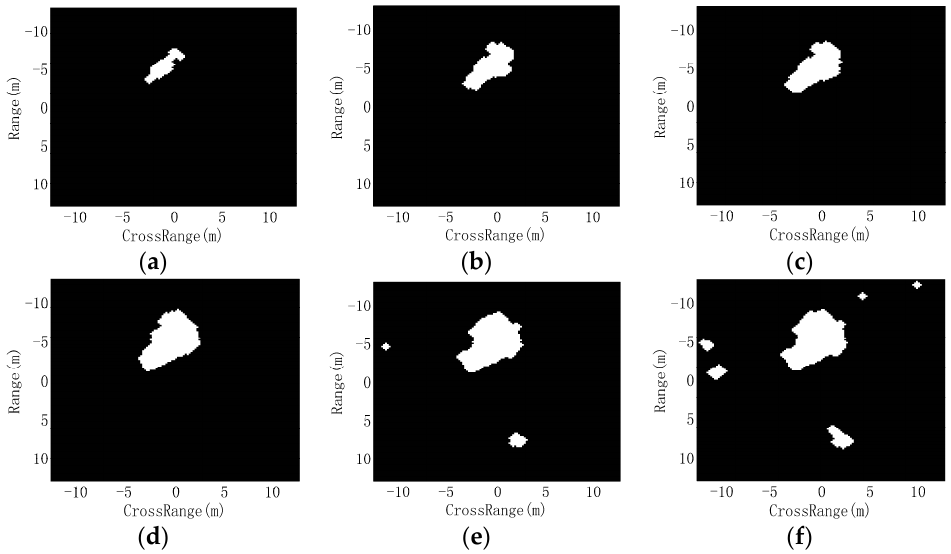
Figure 10. Segmented shadow regions at different thresholds: ( a ) 50%; ( b ) 70%; ( c ) 90%; ( d ) 110%; ( e ) 130%; and ( f ) 150% (of the original threshold).